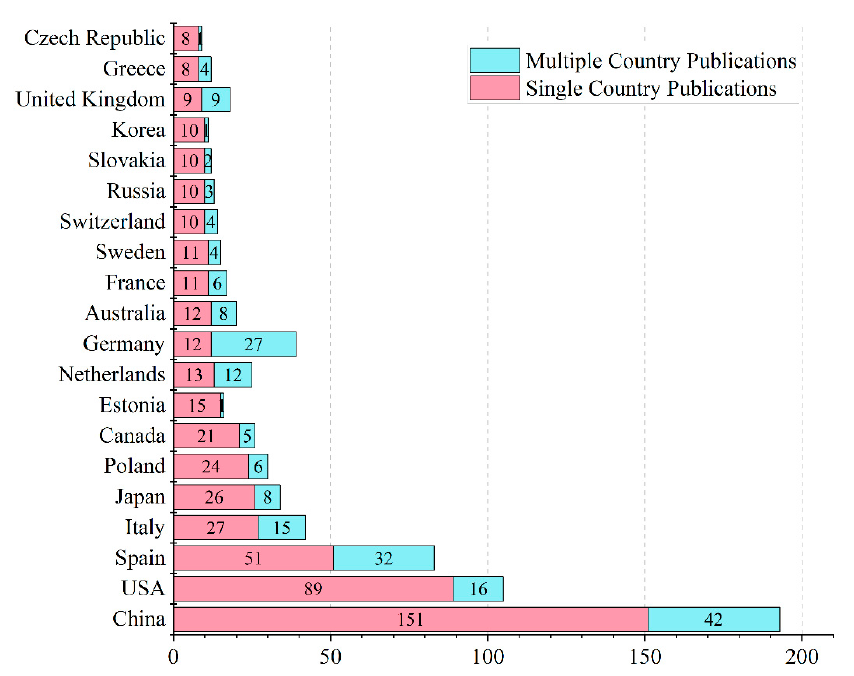
Figure A1. Number of independent and cooperative publications in the 20 countries with the most published articles from 1980 to 2021 .